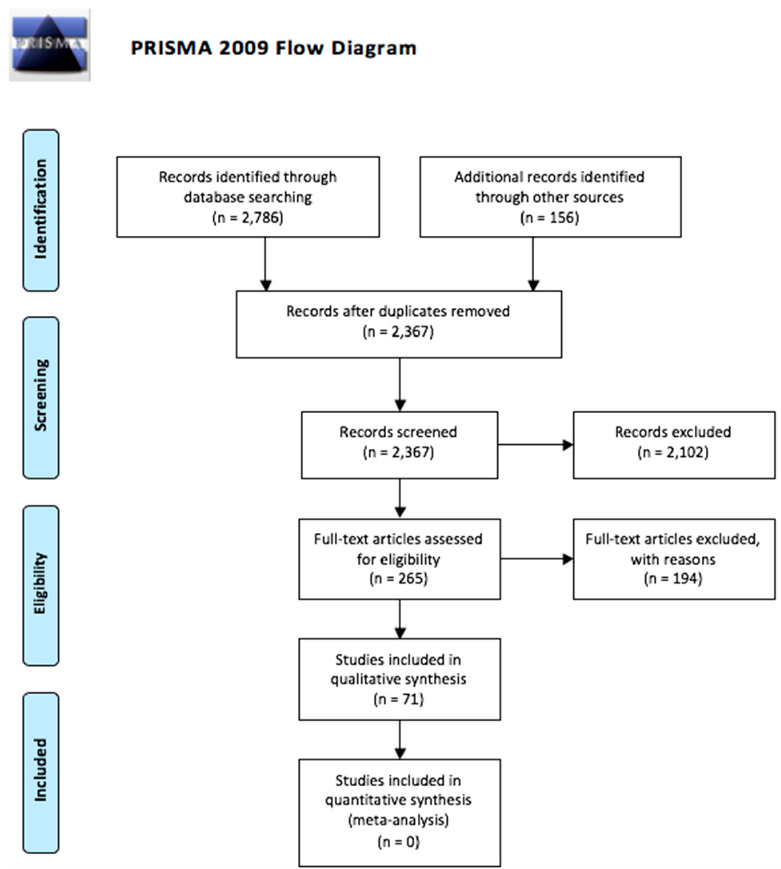
Figure 1. PRISMA flow diagram.